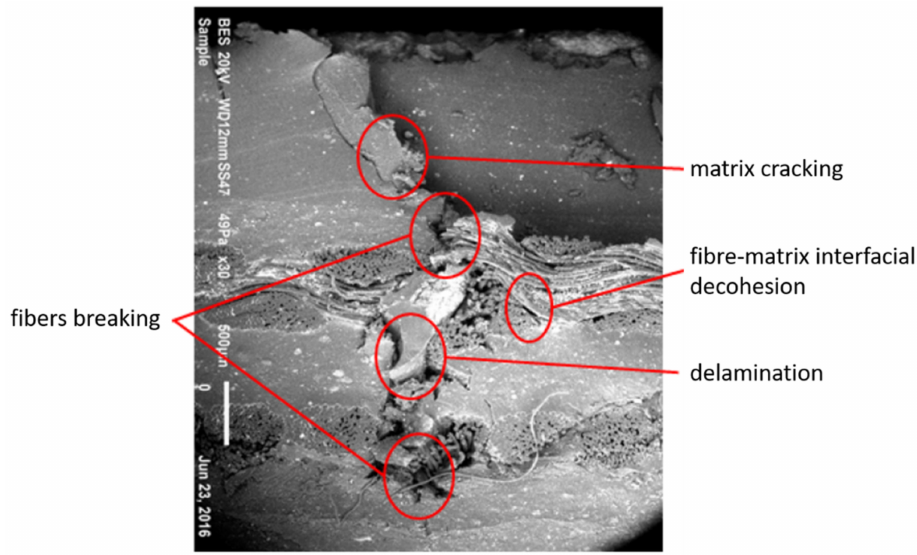
Figure 2. Micrograph of the cross-sectional area of the impacted specimen at 48.51 Joule.